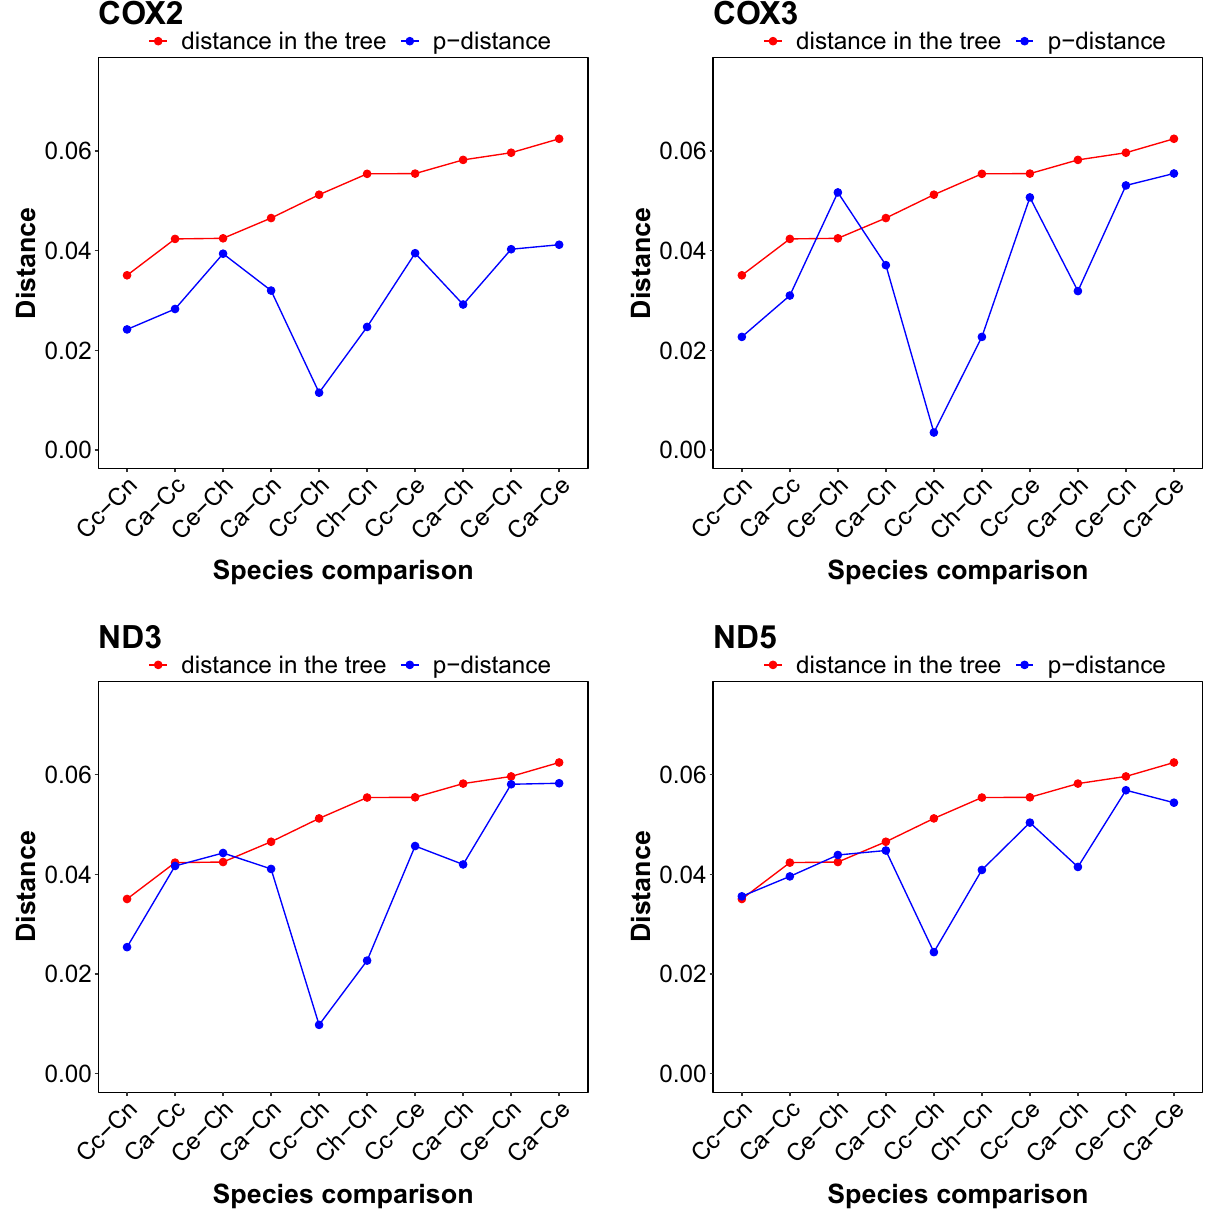
Figure 3. Comparison of p-distances for all pairs of Cervus species with the distances obtained from the MrBayes phylogenetic tree for selected protein-coding genes. The species pairs were arranged according to the tree distance. Ca— C. albirostris ; Cc— C. canadensis ; Ce— C. elaphus ; Ch— C. hanglu ; Cn— C. nippon. The plots for other genes and the control region are shown in Fig.